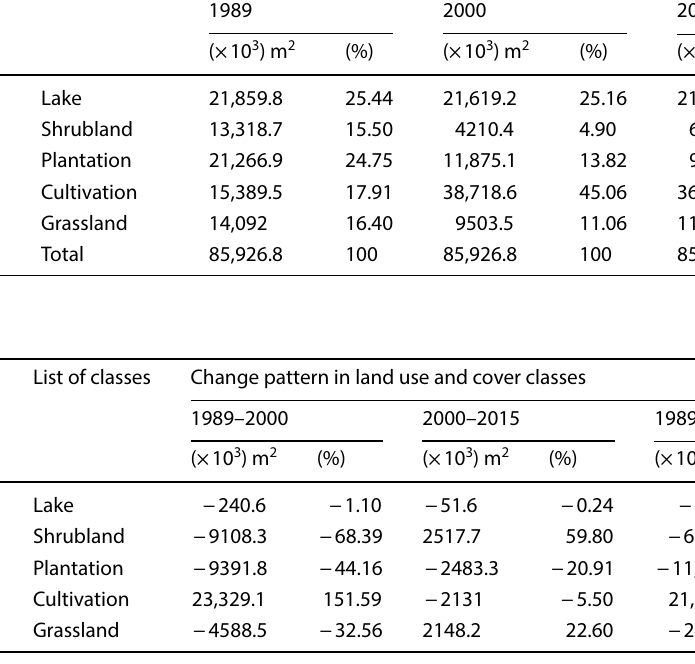
NB: The bold numbers along the diagonals in Tables 2, 3 and 4 denote points that have been appropriately categorized using reference Table 5 Spatial coverage of land use and cover classes of Hayk Lake basin